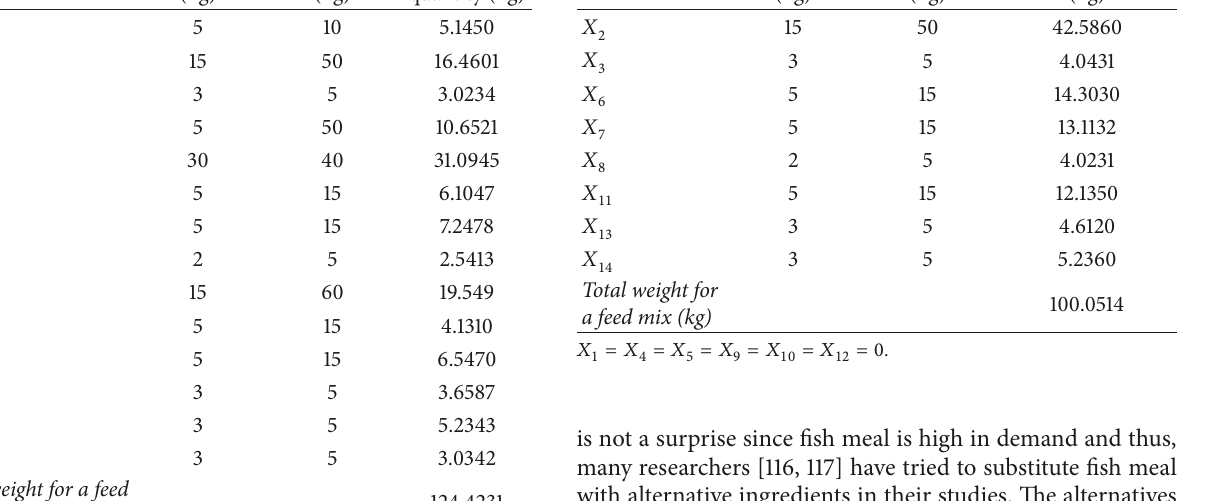
Table 5: A sample solution obtained from the EA-SR model. Ingredient